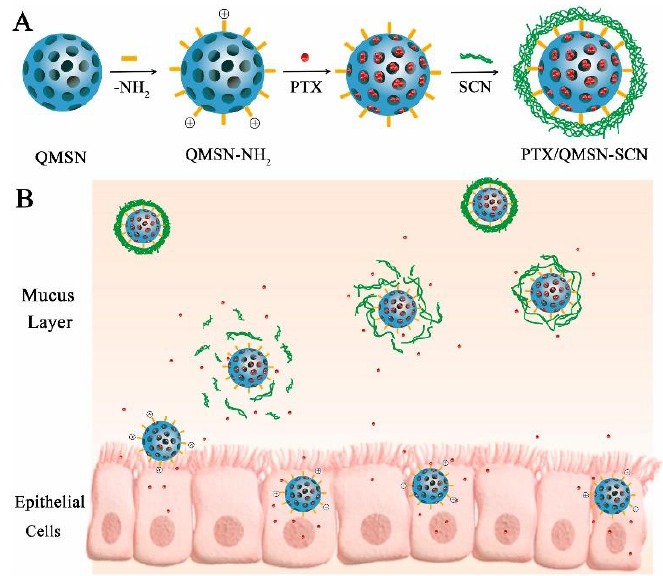
Figure 17. Scheme of protein-decorated mesoporous silica nanoparticles preparation ( A ) and its intestinal uptake ( B ) (here QMSN = CdSe/ZnS quantum dots doped mesoporous silica nanoparticles; SCN = succinylated casein). Reprinted with permission from [235]. Copyright 2020 Elsevier.